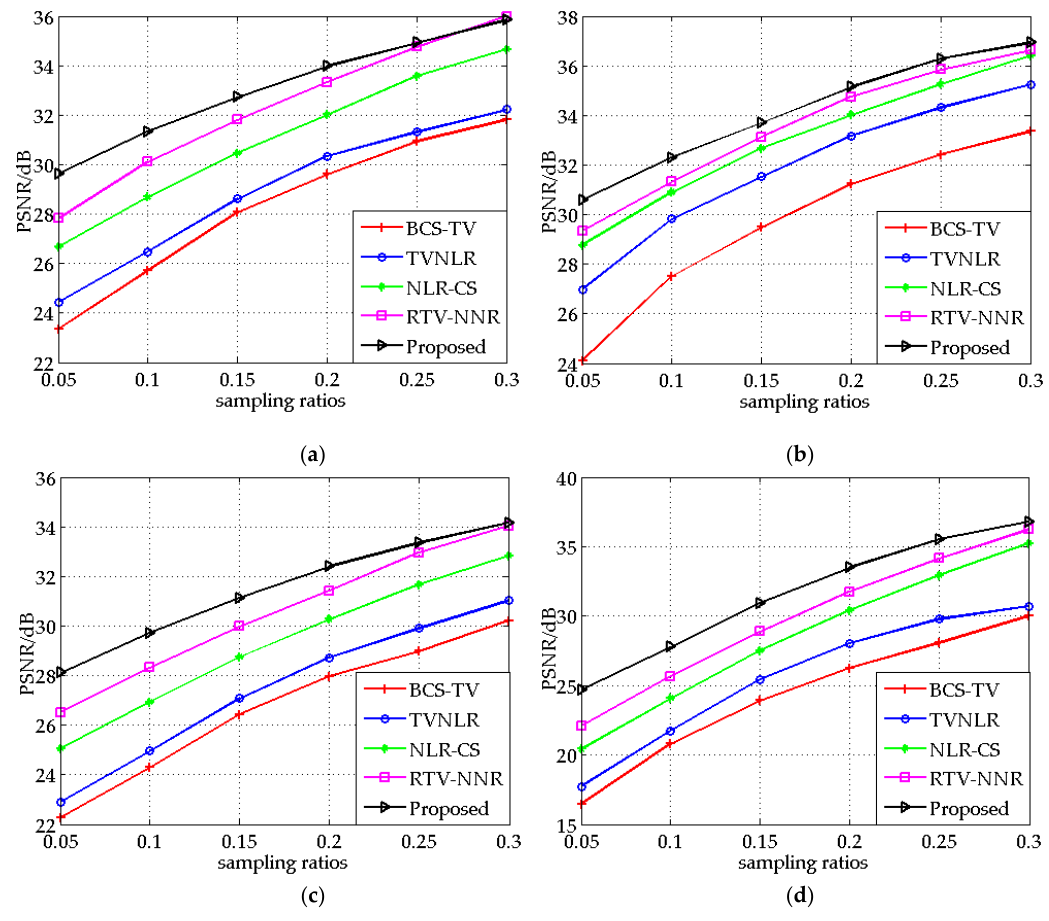
Figure 5. The PSNR curves of four images: ( a ) Lena, ( b ) House, ( c ) Boats, ( d ) Chart2.